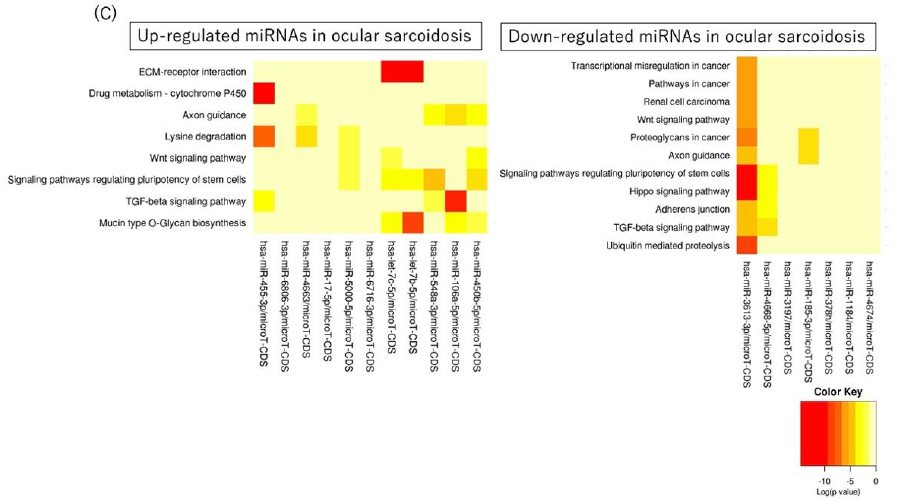
Figure 1. ( A ) Principal component analysis, ( B ) unsupervised hierarchical clustering analysis, ( C ) pathway analysis using serum miRNAs in diagnosed ocular sarcoidosis versus healthy controls. HS: healthy subjects, S: patients with diagnosed ocular sarcoidosis. Table 2. Differential expression of serum miRNAs in diagnosed ocular sarcoidosis versus healthy controls. miRNA